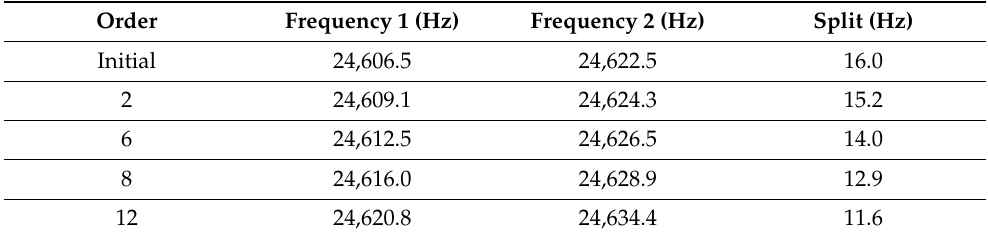
Table 5. Modal frequencies and frequency split recorded during the tuning